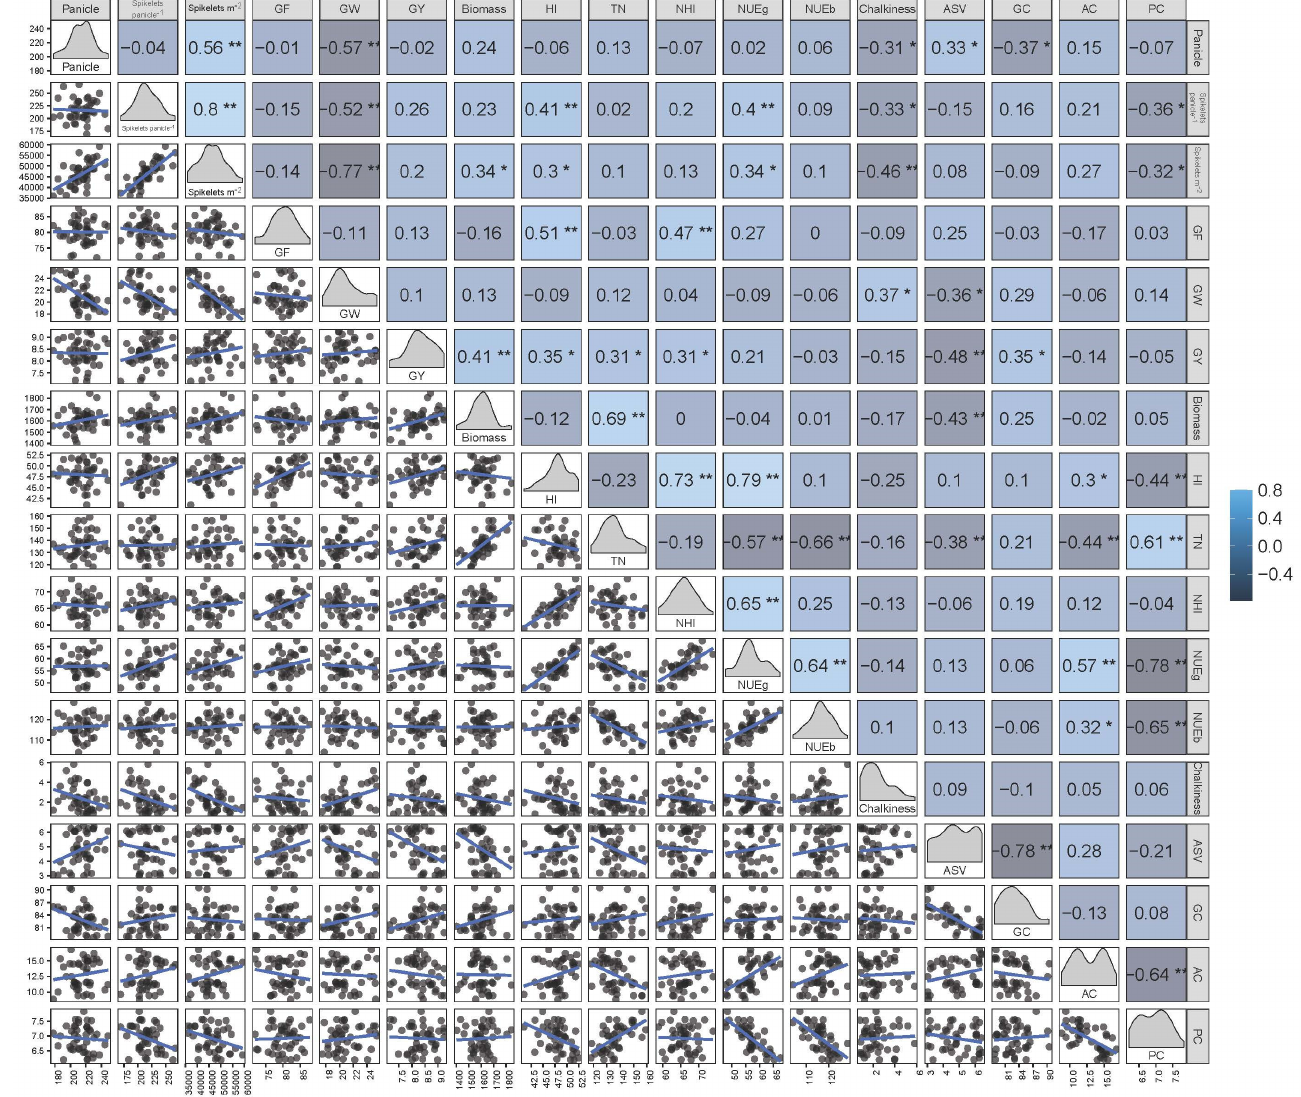
Figure 2. Correlations between parameters related with grain yield, grain quality, and nitrogen use efficiency. * and ** represent significance at p < 0.05 and p < 0.01, respectively. GF: grain filling percentage; GW: grain weight; GY: grain yield; HI: harvest index; TN: Total N uptake; NUEg: nitrogen use efficiency for grain production; NUEb: nitrogen use efficiency for biomass production; ASV: alkali spreading value; GC: gel consistency; AC: amylose content; PC: protein content.